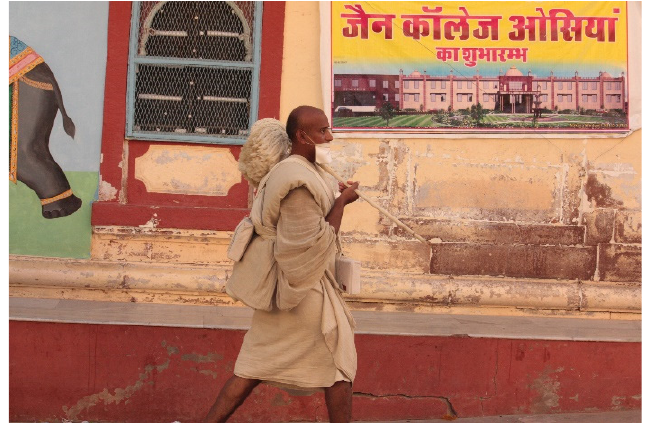
Figure 2. Jain lay follower performing m ū rti p ū j ā wearing a muhpatt ī . Internet photo.